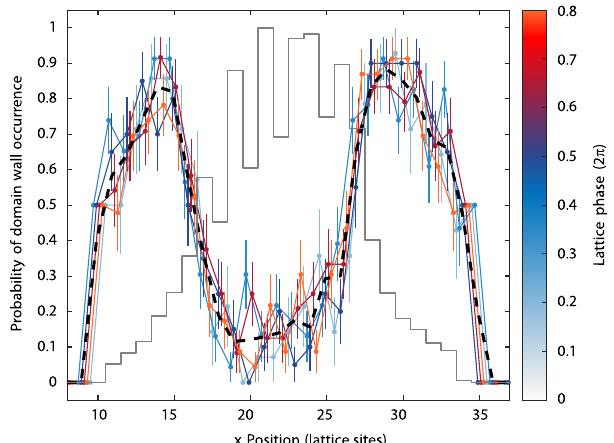
FIG. 10. Spatial distribution of the domain walls. Spatially resolved analysis of the data of Fig. 2. The curves show the probability of finding a domain wall at a given position in the cloud after integrating along the direction of the stripes. The color denotes the postselected phase of the lattice and the dashed line is the average over all data. The probability is almost homogeneous in the central region (example density shown by black curve) and trivially increases at the edge of the cloud where the density-wave pattern vanishes. The error bars denote the standard deviation of the mean.